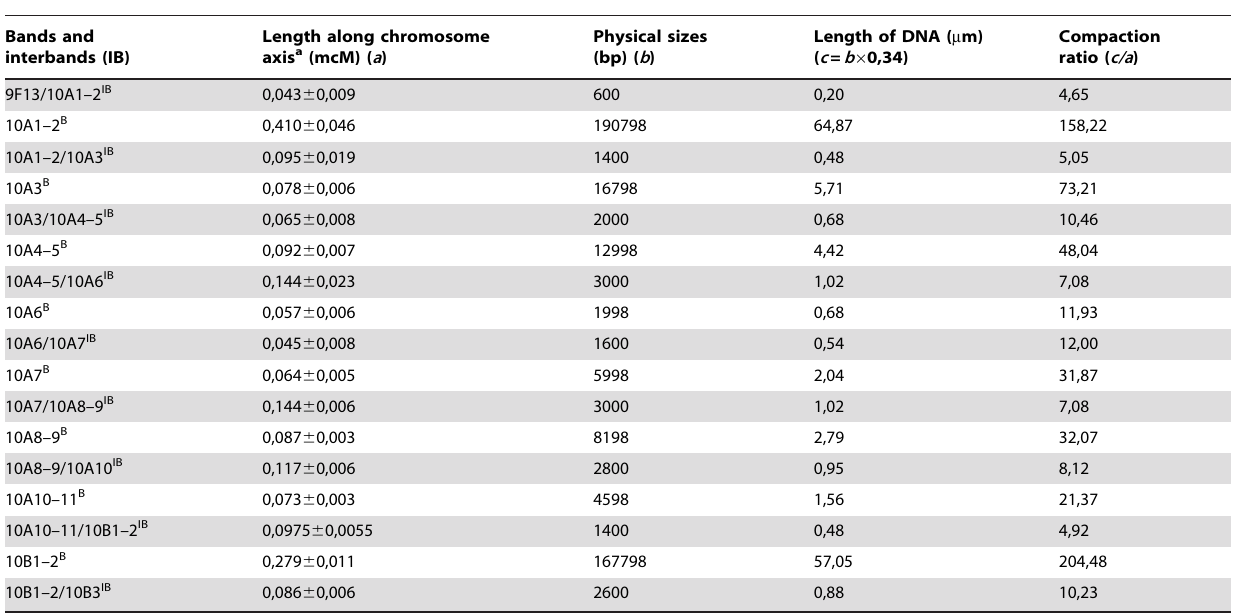
Table 2. DNA compaction ratio of the bands in the 9F13 -10B3 region.